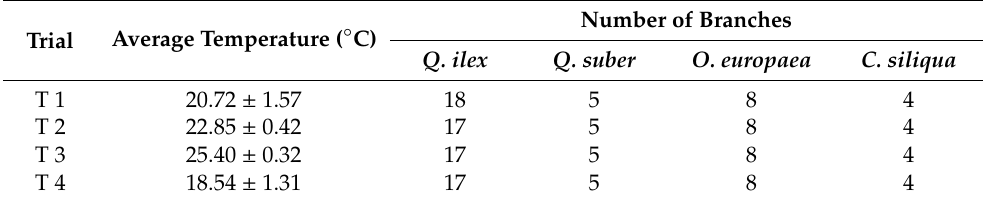
Table 2. Average temperature ( ◦ C) ± standard error (SE) and number of branches of each tree species used in the trials